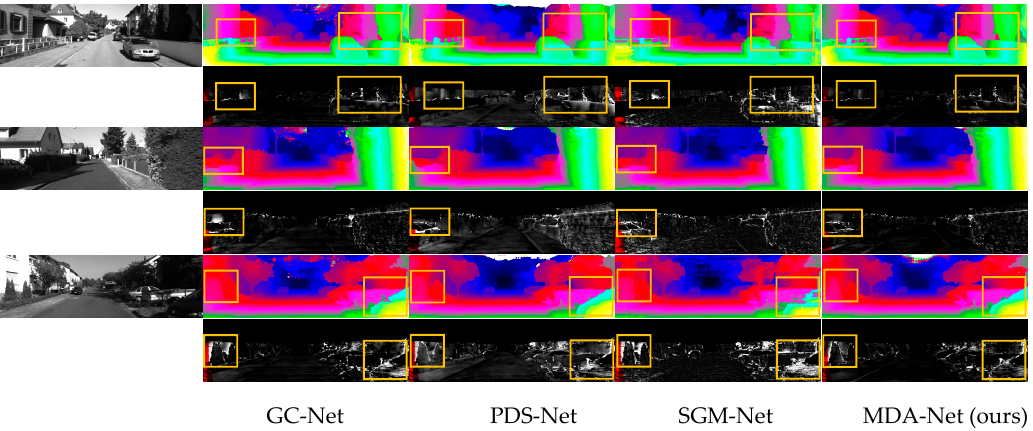
Figure 8. Visualizations of the depth results of KITTI stereo 2012 test set. The first column shows the left images.